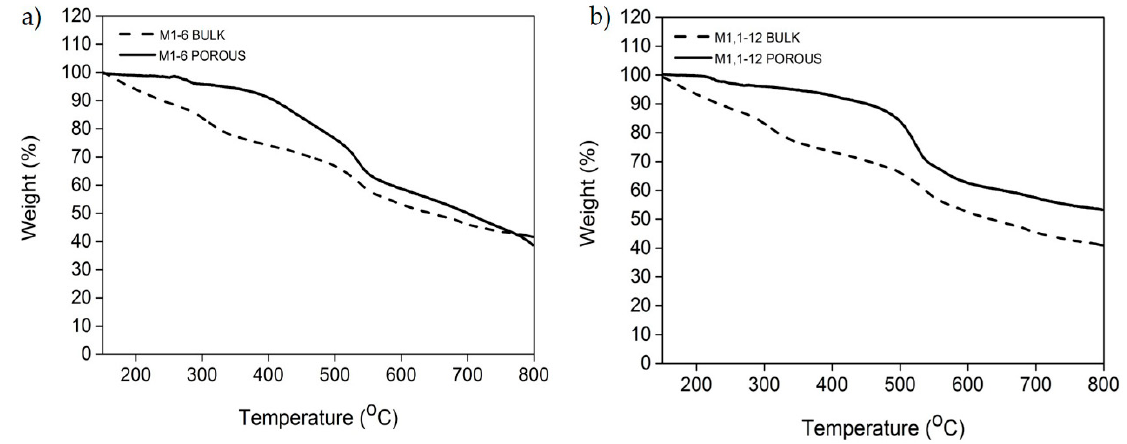
Figure 10. TGA curves of the bulk and porous membranes ( a ) M1-6; and ( b ) M1,1-12.